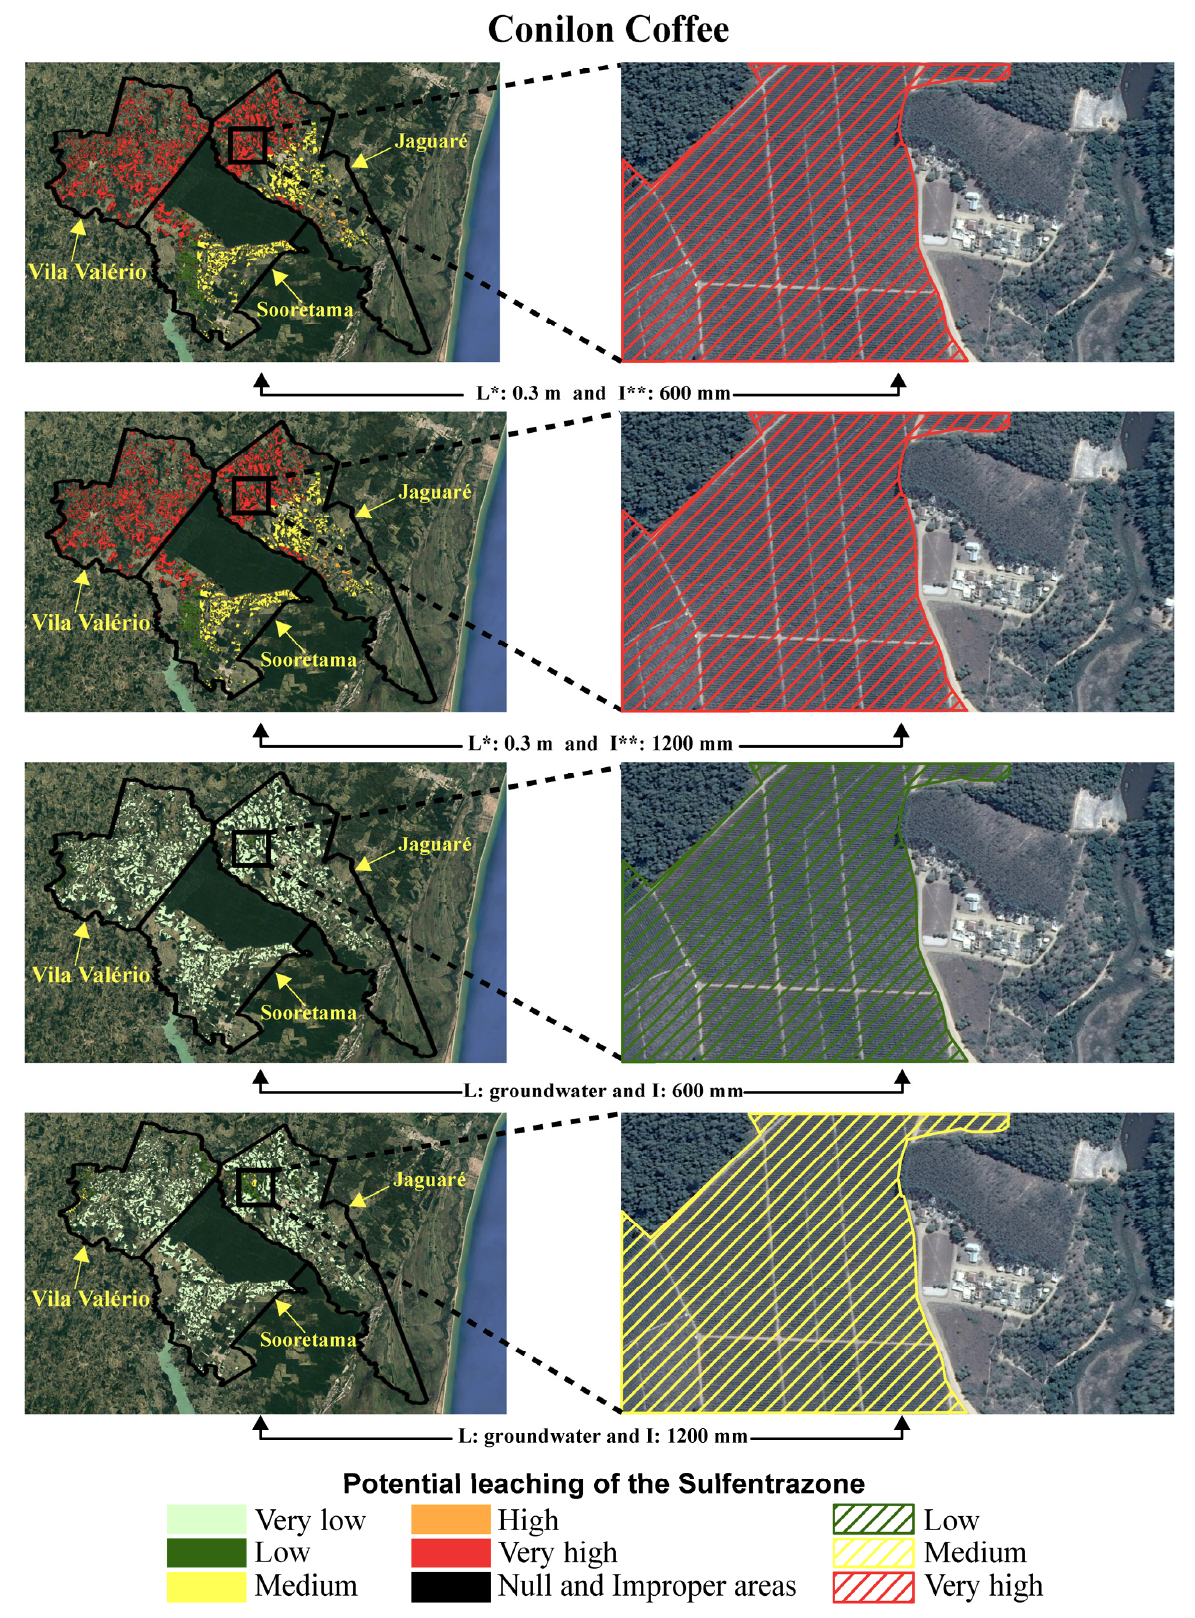
Figure 4. Attenuation Factor ( AF ) of active ingredient sulfentrazone evaluated for an extended study area cultivated with conilon coffee ( Coffea canephora Pierre ex Froehner) for the municipality of Jaguar é , ES, Brazil. * L: Groundwater depth and ** I: